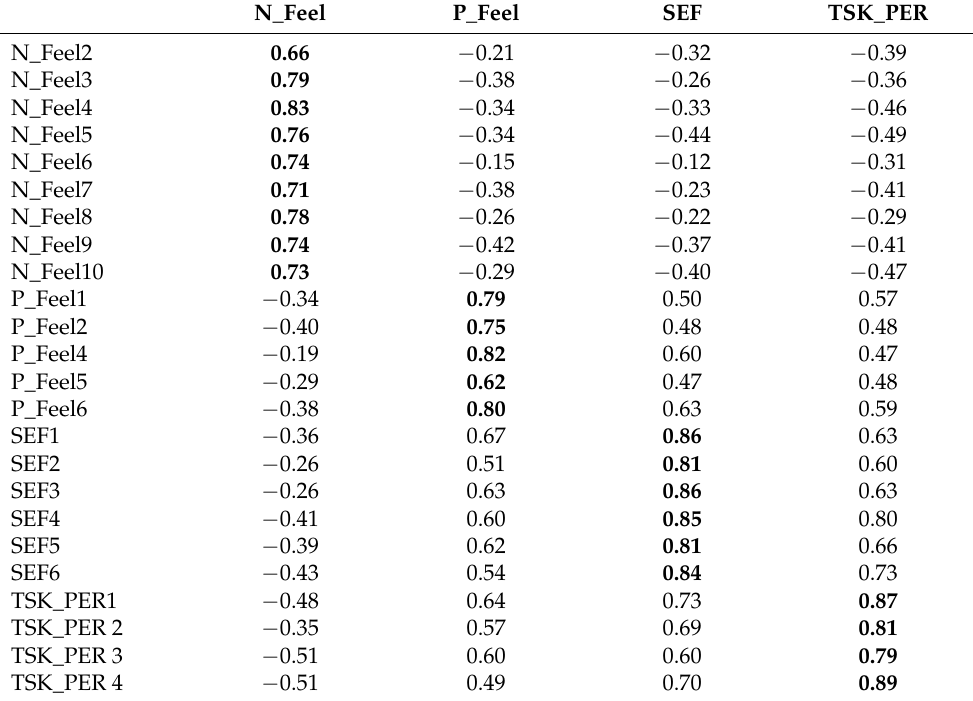
Table 6. Discriminant validity with cross-loading analysis.